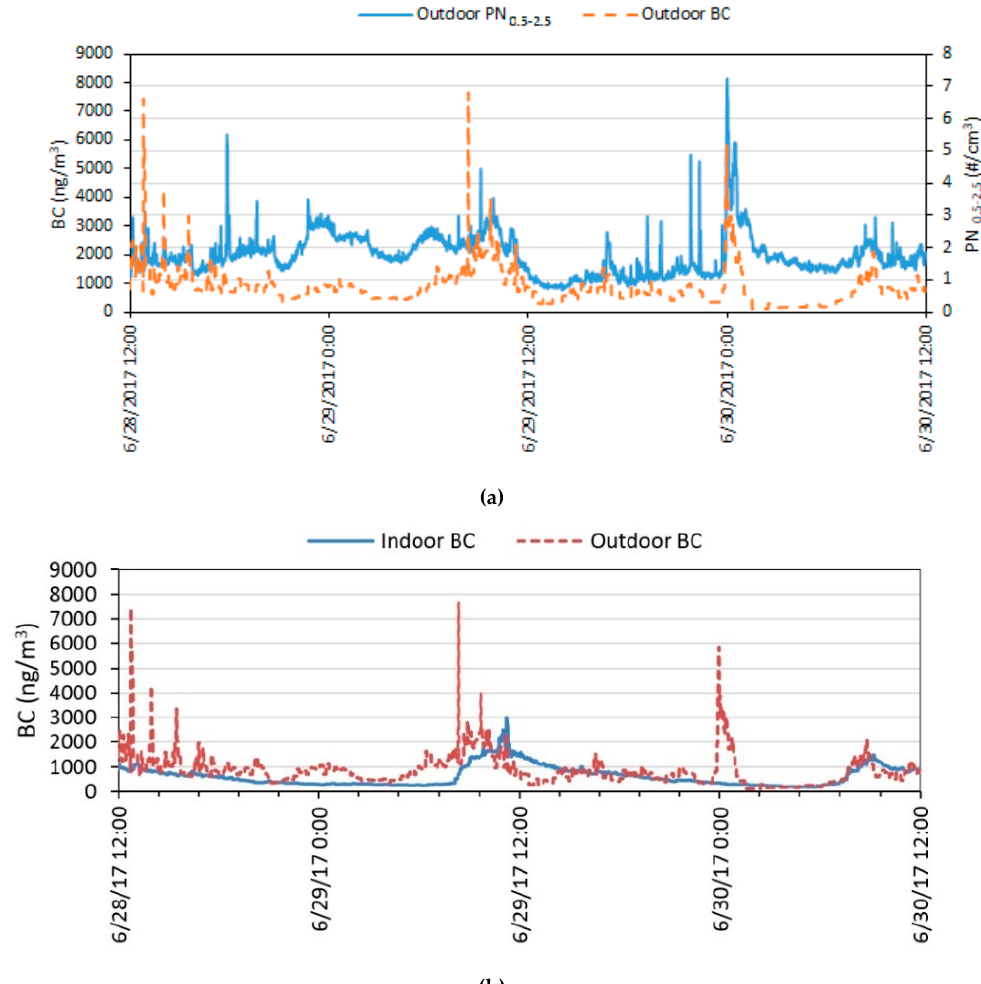
Figure 6. Time series profiles of black carbon from one of the test homes (Home ID: T109). ( a ) Compares the outdoor concentration profiles of black carbon (BC) and PN 0.5–2.5 , and ( b ) compares the indoor and outdoor BC profiles.